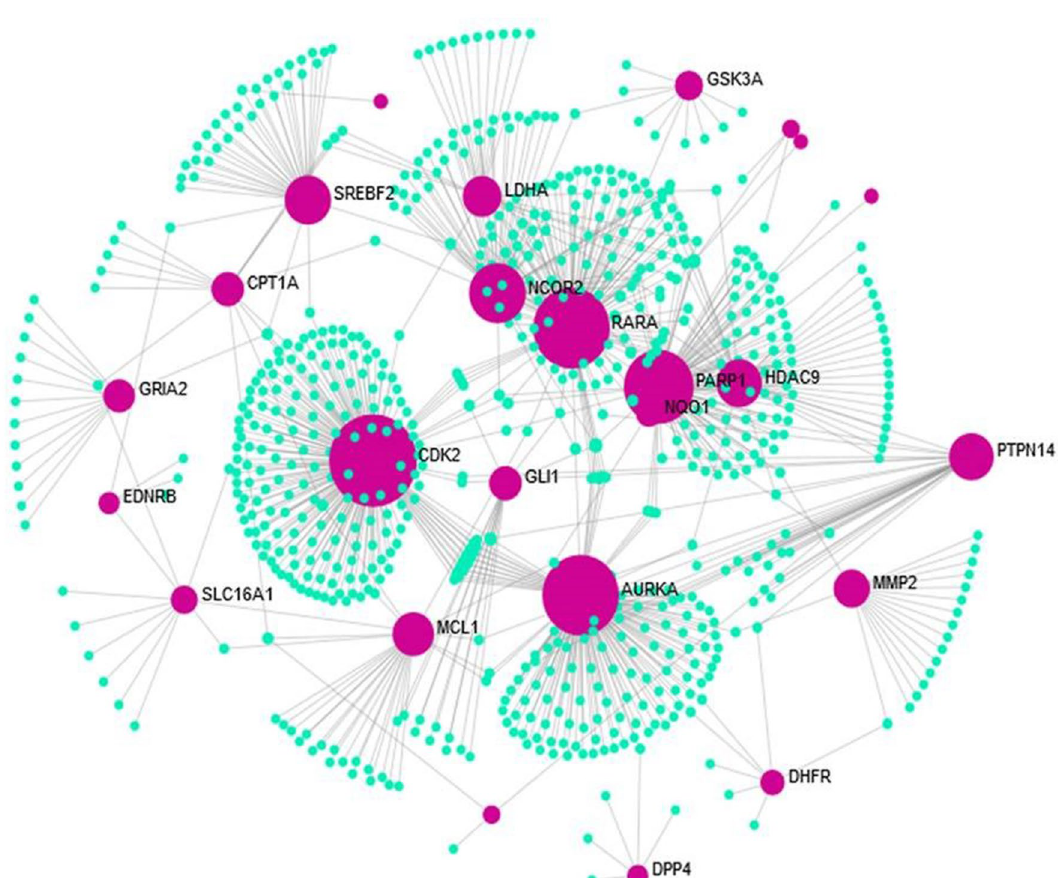
Figure 7. Tissue specific PPI obtained from Network Analyst. The pink colour in the image represents the significant immune responsive genes whereas the green color represents the interacting partners present in the human whole blood